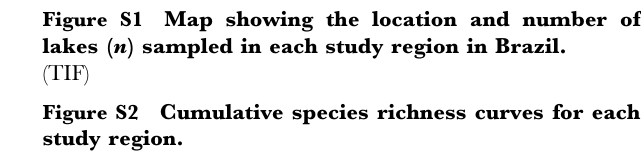
Figure S1 Map showing the location and number of lakes ( n ) sampled in each study region in Brazil. Figure S2 Cumulative species richness curves for each study region. Figure S3 Gamma and alpha diversities for each region. (A) Zooplankton gamma diversity for each region, sampling time (for each region, the different data points in the X-axis represent the different sampling times) and lake categories (permanent connected, permanent isolated and temporary isolat- ed). (B) Mean zooplankton alpha diversity (as the mean Simpson distance to group centroid) for each region, sampling time and lake categories. The error bars represent the standard errors of the mean over aquatic environments. Figure S4 Mean species richness and abundance for each zooplankton group. (A) Mean number of species for each zooplankton group (Rotifera, Cladocera, Copepoda), region (Trom, Trombetas; Par, Parana´; Arag, Araguaia; Mac, Macae´; Car, Caraja´s) and lake category (P, permanent; T, temporary). (B) Mean abundance (ind/mL) for each group, region and lake category. The error bars represent the standard errors of the mean over aquatic environments. Figure S5 Zooplankton beta diversities (as the mean Bray-Curtis and Simpson distances to group centroid) for each region. (A) Zooplankton beta diversity (as the mean Bray-Curtis distance to group centroid on biological data based on log 10 transformation) for each region, sampling time (for each region, the different data points in the X-axis represent the different sampling times) and lake categories (permanent connect- ed, permanent isolated and temporary isolated). (B) Zooplankton beta diversity (as the mean Simpson distance to group centroid) for each region, sampling time and lake categories. Figure S6 Local contribution to beta diversity (LCBD) for Trombetas, Parana´ and Araguaia regions. Maps of Trombetas, Parana´ and Araguaia regions during high and low water periods showing the local contributions to beta diversity (LCBD) of the zooplankton community at the study lakes. Size of the circles is proportional to the LCBD. Lakes in red have